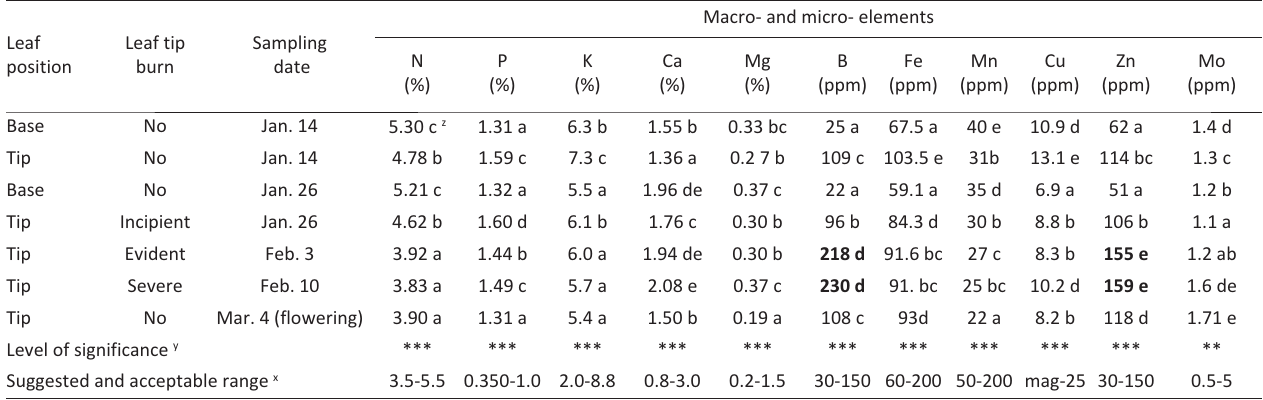
z Comparisons of means by Duncan’s multiple range test, P <0.01, F ­test. y ***, ** = significant at P < 0.001, and P <0.01, F ­test. x JR Peter’s Laboratory (Allentown, PA.